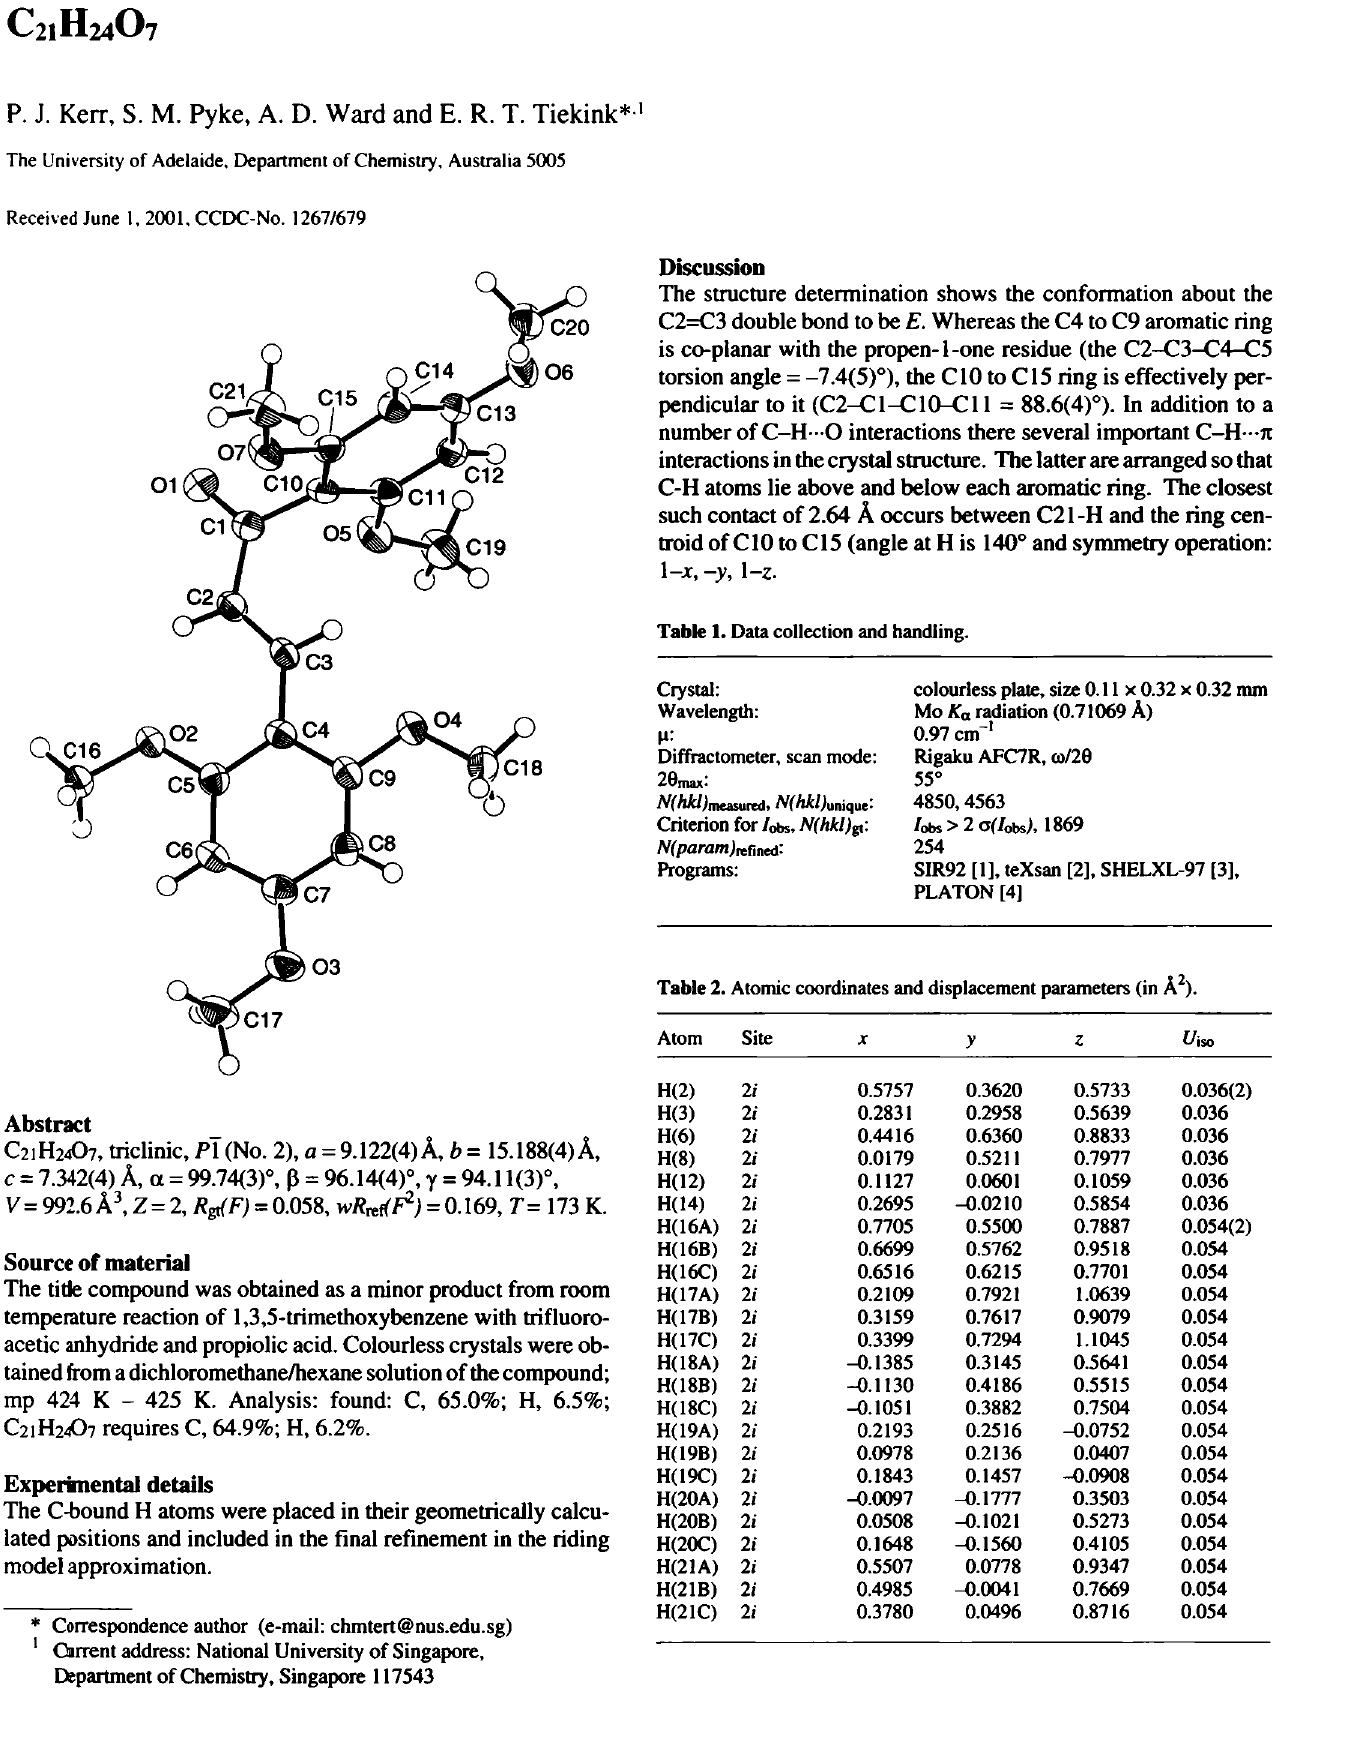
Table 1. Data collection and handling.